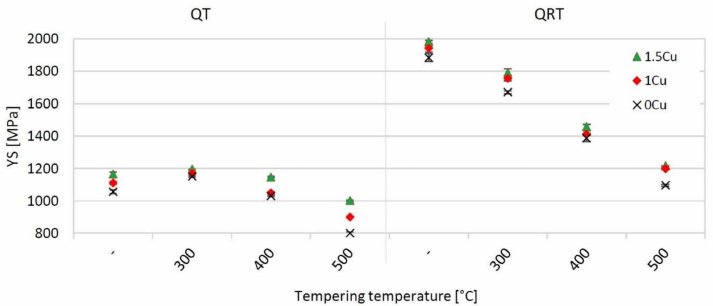
Figure 1. Yield stress (YS) of samples without tempering and after tempering at di ff erent temperatures for 60